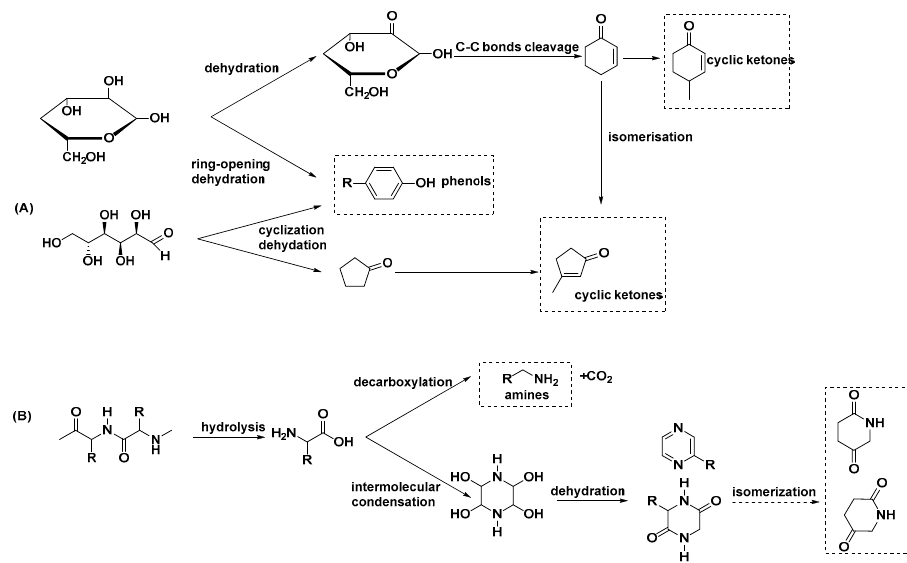
Figure 5. Plausible pathways for bio-oils formation via hydrothermal liquefaction (Adapted from Kruse et al. [69]).